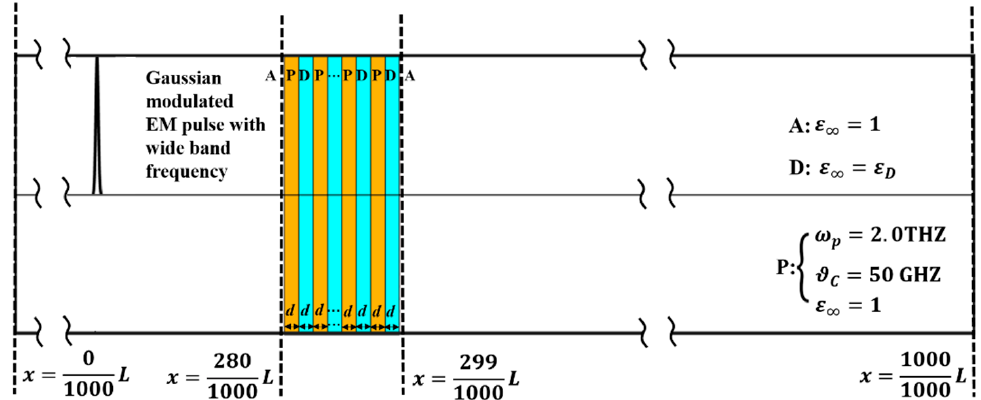
Figure 2. Schematic of an incident Gaussian pulse and computational domain of 1D plasma PhCs. (The entire domain is 2.3 mm long, with a grid spacing of 23 nm).